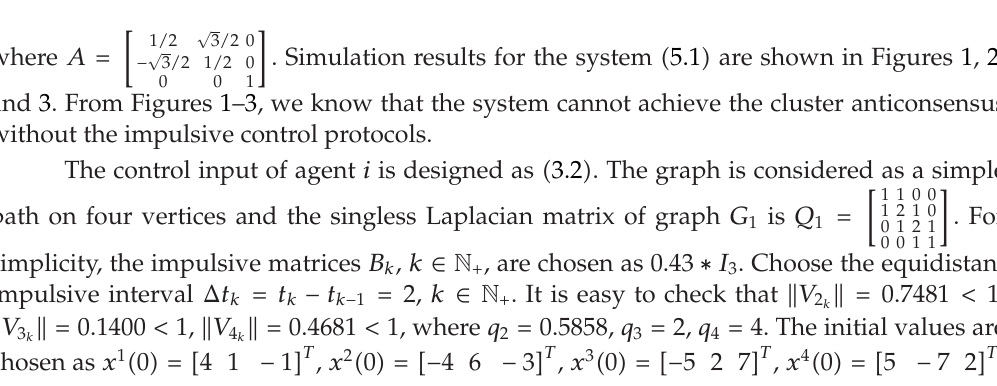
(cid:6) t (cid:7) , i (cid:9) 1 , 2 , 3 , 3